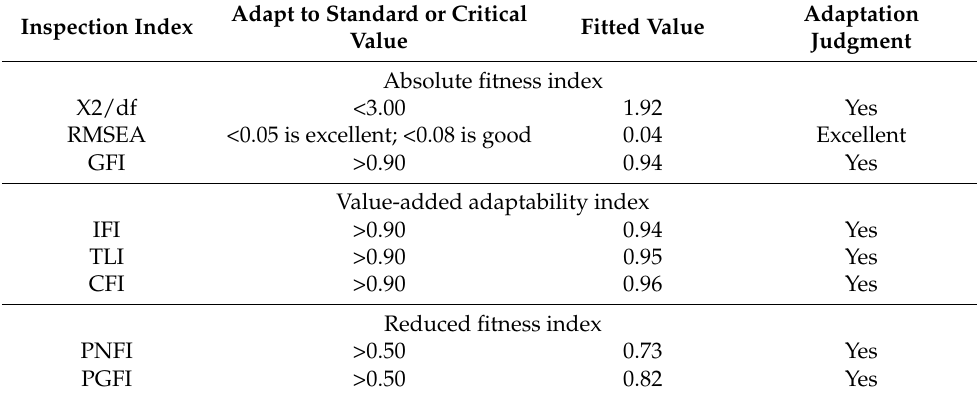
Table 3. Fitting index results for the structural equation model.